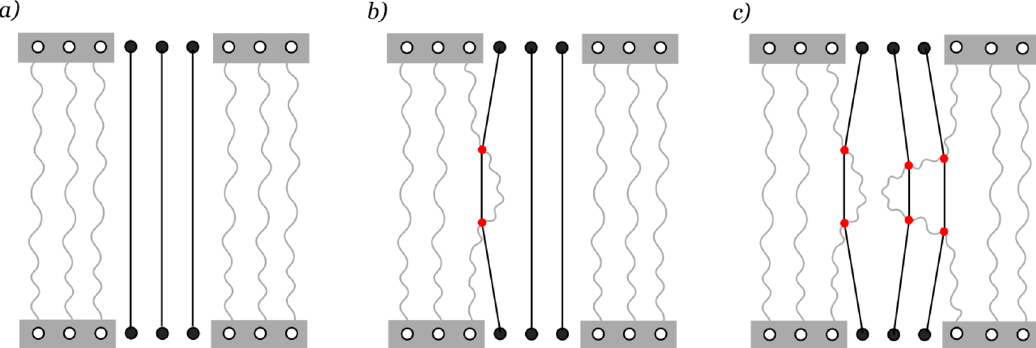
Figure 10 . Left/right hopping of l = 3 hard magnons/bridges in presence of reservoirs of holes/gluons. a) m = 0 steps, no interaction, order s 0 . b) m = 2 steps, emitted and absorbed magnon, order s 2 ’ λ . c) m = 6 steps. The order in which the vertices occur in the time-direction (up-down) matters and counts different paths. The number of such paths is ( bridge stampedes ) l,m discussed in the